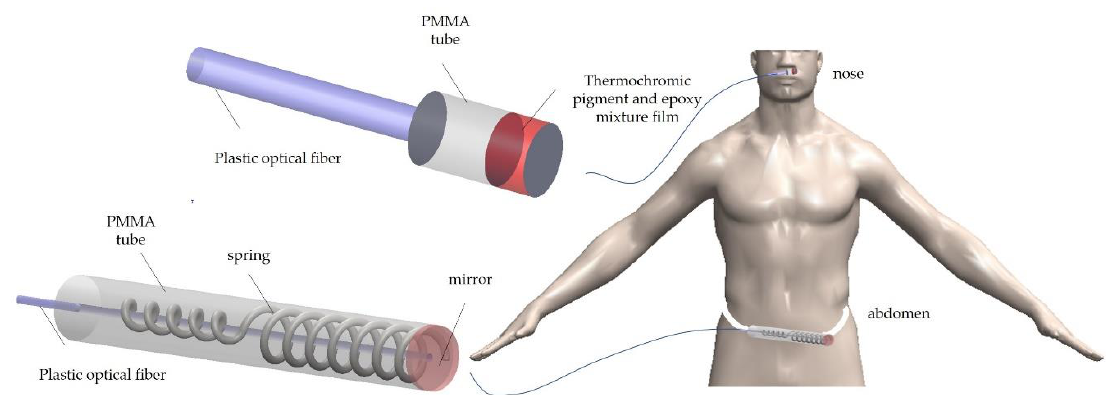
Figure 9. Schematic drawing of the structures of the nasal-cavity and abdomen-attached fiber-optic sensors (Adapted from [146].)